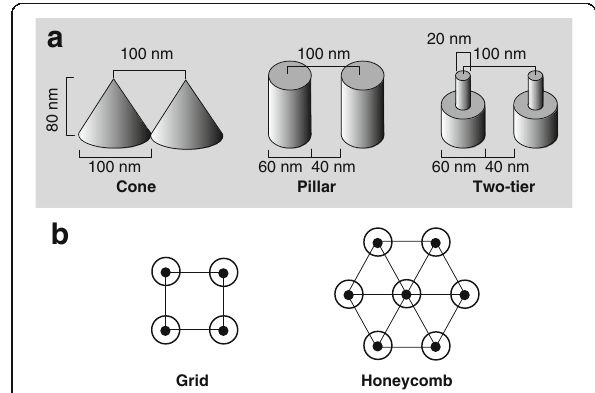
Fig. 4 a Simplified 3-dimensional models of the nipple array for the simulation of light reflection. b Grid and honeycomb patterns of the arrays for the